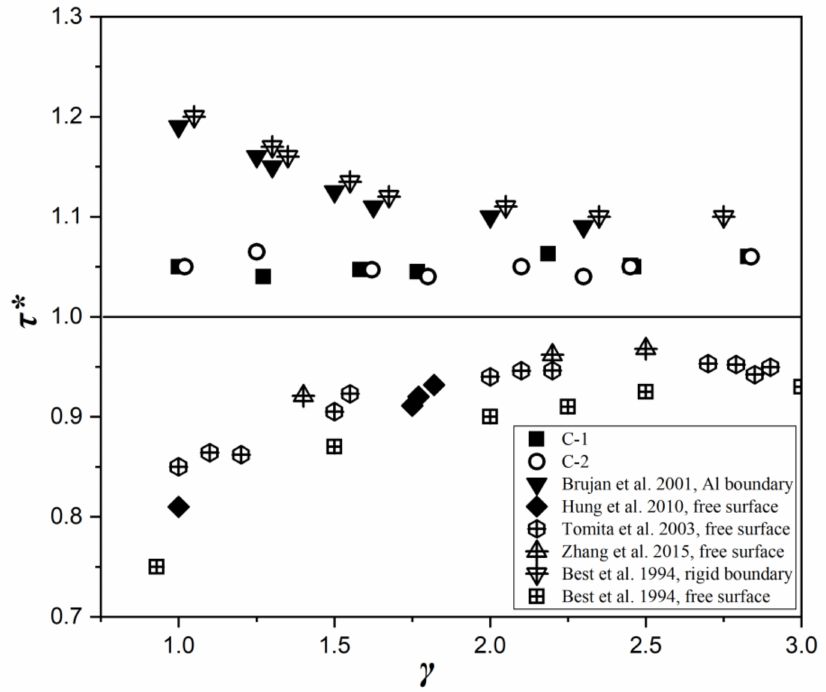
Figure 7. Comparison of bubble collapse time near composite plates with different ply